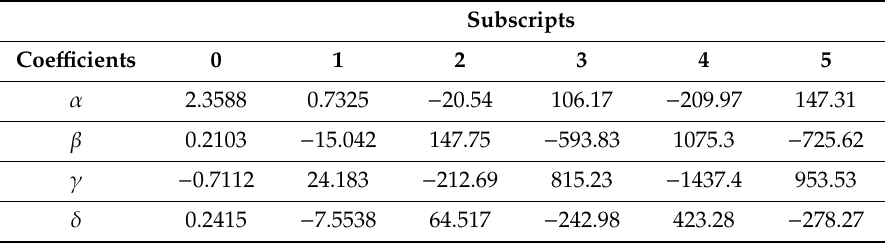
Table 5. Table of coe ffi cients for normalized M-factor, external surface crack.